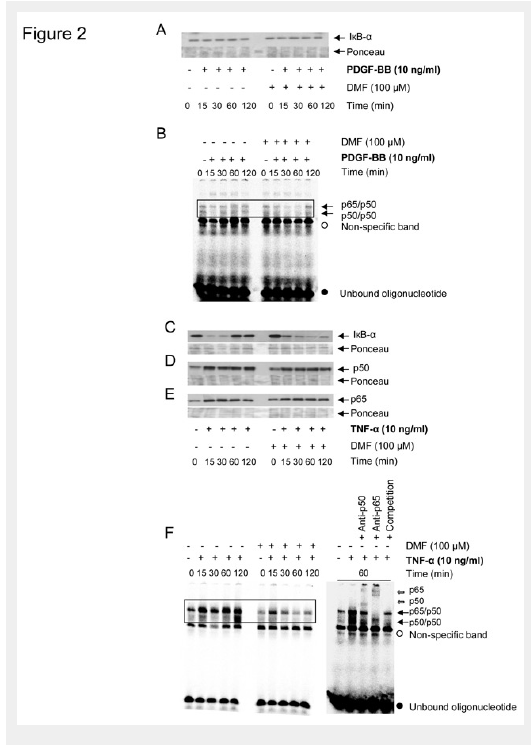
Figure 2 PDGF-BB (A, B) or TNF-α (C-F) specific effects of DMF (100 µM) on IĸB-α degradation, NF-ĸB p65/p50 nuclear entry and NF-ĸB to DNA binding in lung fibroblasts (n = 3). IĸB-α degradation in total cell lysates (A, C), and nuclear entry of NF-ĸB p65/p50 in nuclear cell lysates (D, E) are depicted as representative immuno-blots and similar results were obtained with two additional cell